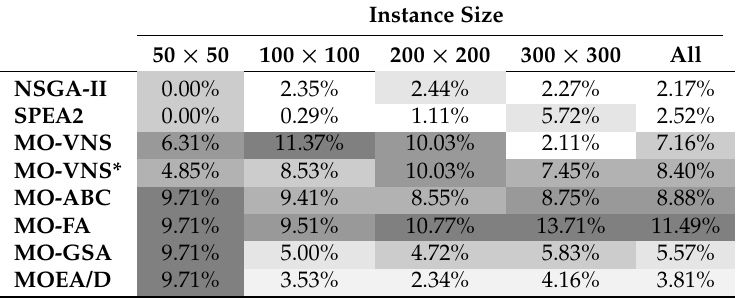
Table 4. Based on hypervolume, percentage of average test cases where a metaheuristic is significant better than any other solving the bi-objective